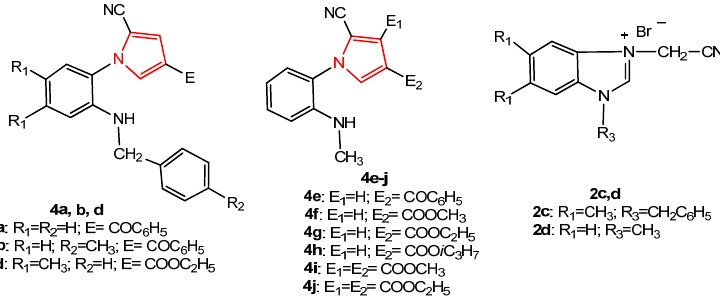
Figure 9. The structure of the pyrrole derivatives tested for antitumor activity.